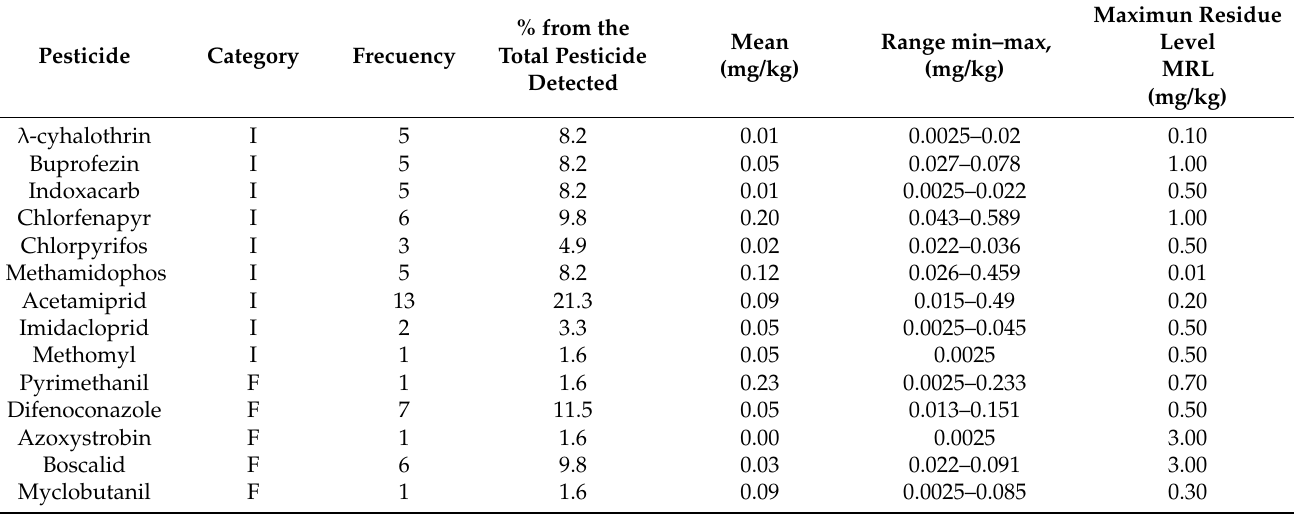
Table 1. Distribution and pesticide residues levels detected in fresh tomatoes.